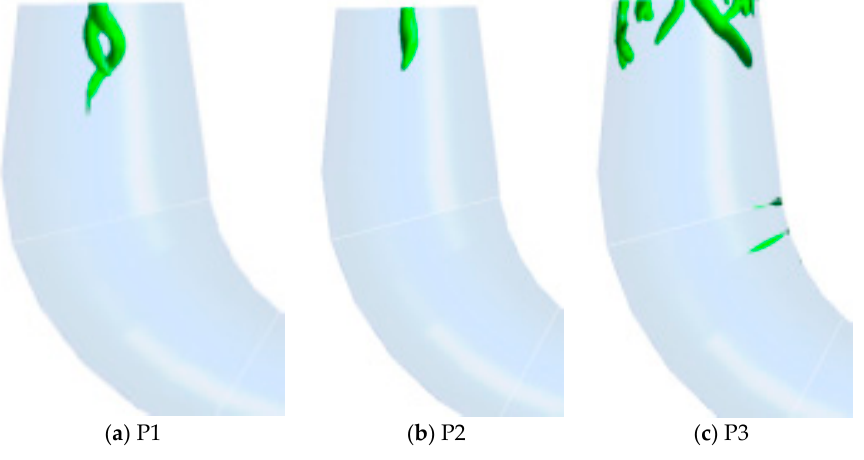
Figure 15. Draft tube vortex in different operating points.